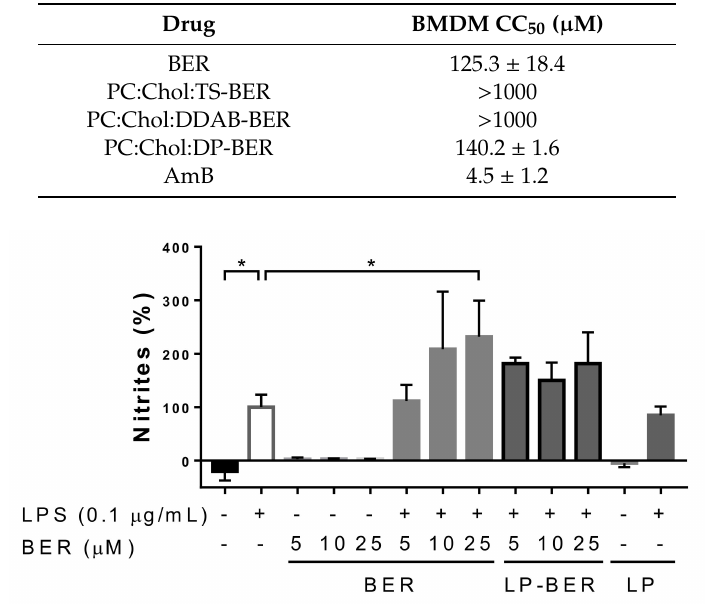
Table 3. In vitro cytotoxicity (CC 50 ) of free BER, PC:Chol:TS, PC:Chol:DDAB, PC:Chol:DP liposomes